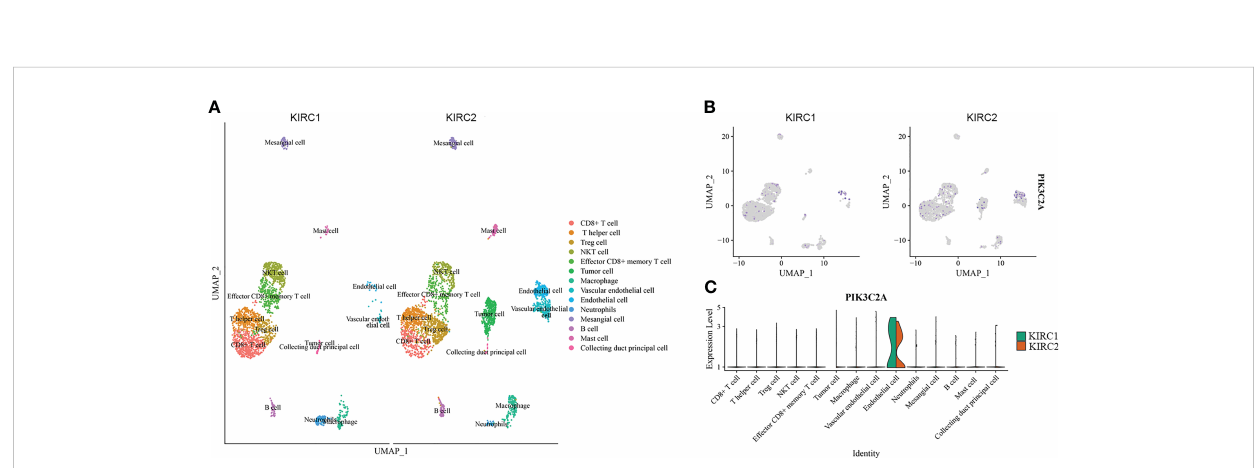
FIGURE 3 The expression of PIK3C2A in scRNA data. (A) Uniform manifold approximation and projection (UMAP) visualization of cells from the right (KIRC1) and left (KIRC2) KIRC tissues (KIRC2). (B) The expression pattern of PIK3C2A was plotted in the UMAP plot. (C) Expression level of PIK3C2A in different cell subgroups of KIRC